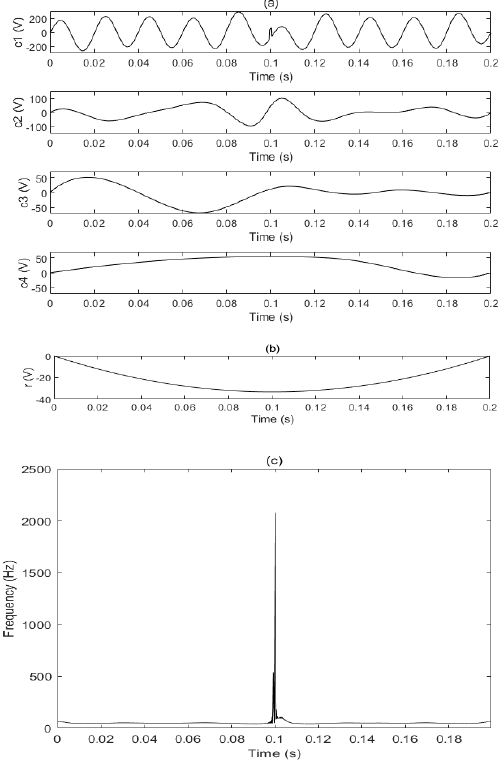
Figure 7. Impulsive transient IMF components ( a ), margin ( b ), and frequency parameter ( c ).